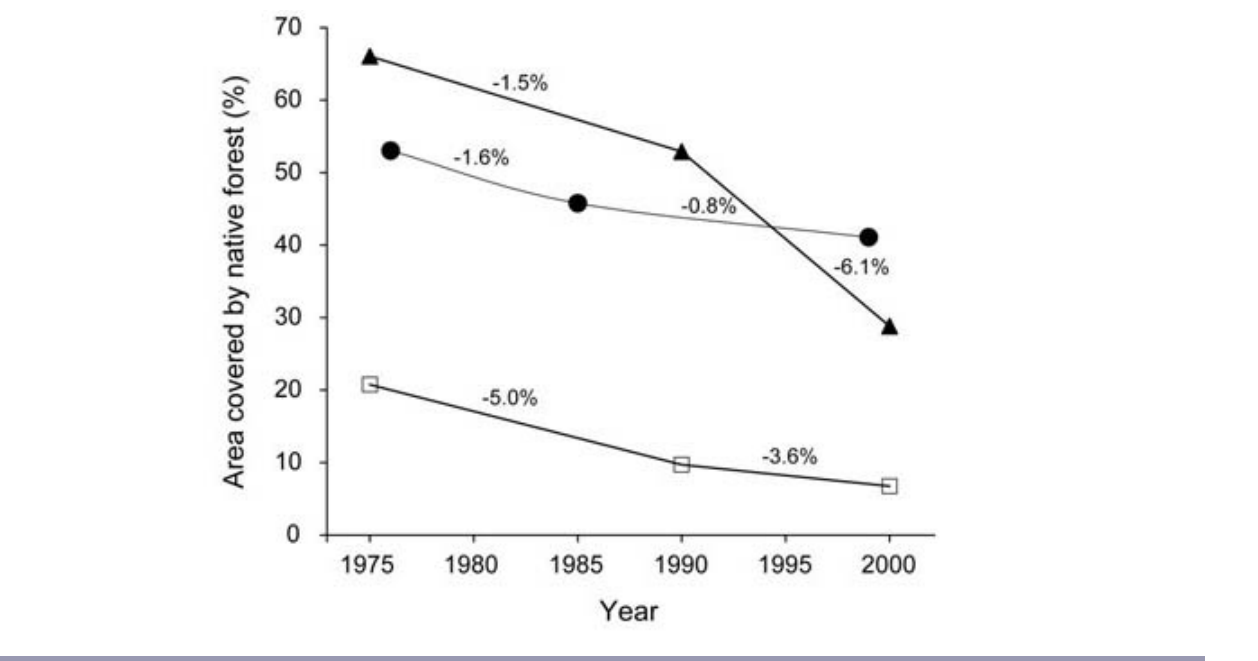
Fig. 3. Loss of forest cover in three study areas, estimated from analysis of satellite remote-sensing imagery. Symbols: filled circle, Los Muermos-Ancud; filled triangle, Chiapas; empty square, Maule. Note that the percentage values given on the figure itself represent annual rates (% per year) of forest